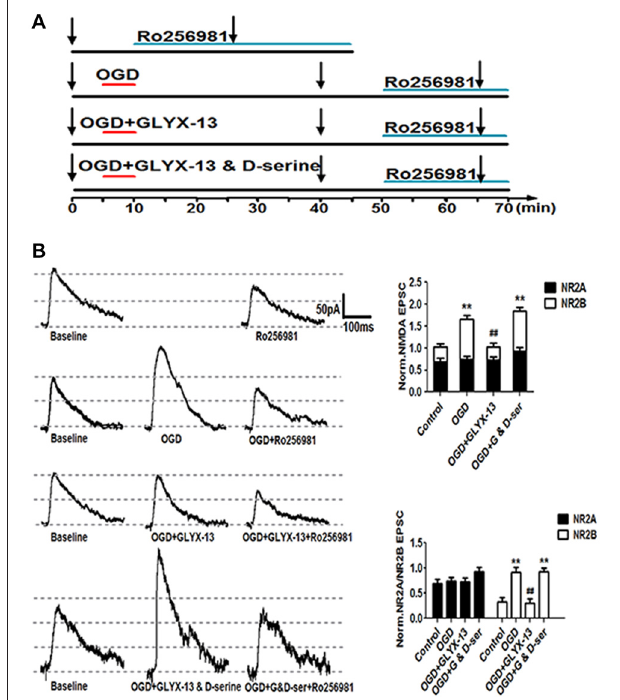
FIGURE 10 | GLYX-13 suppressed the elevation of NR2B-containing NMDA receptors (NMDARs) component induced by OGD treatment. (A) Schematic paradigms showed experimental protocols adopted to detect the NR2 subunit components under control, OGD, OGD with 10 µ mol/L GLYX-13, OGD with co-application of GLYX-13 and D-serine (100 µ mol/L). Selective NR2B subunit antagonist Ro256981 (20 nmol/L) was used to exhibit the amplitude NR2A and NR2B (total amplitude subtract NR2A) containing NMDARs mediated EPSCs in CA1 neurons. The arrows in the paradigm represent the time points to record EPSCs. (B) Sample traces were presented and normalized NMDA EPSCs of total NMDA EPSCs, NR2A and NR2B-containing NMDAR subunit component under various conditions. ( n = 5, one-way ANOVA and Newman-Keuls post test, ∗∗ p < 0.01, compared with control; ## p < 0.01, compared with OGD group).